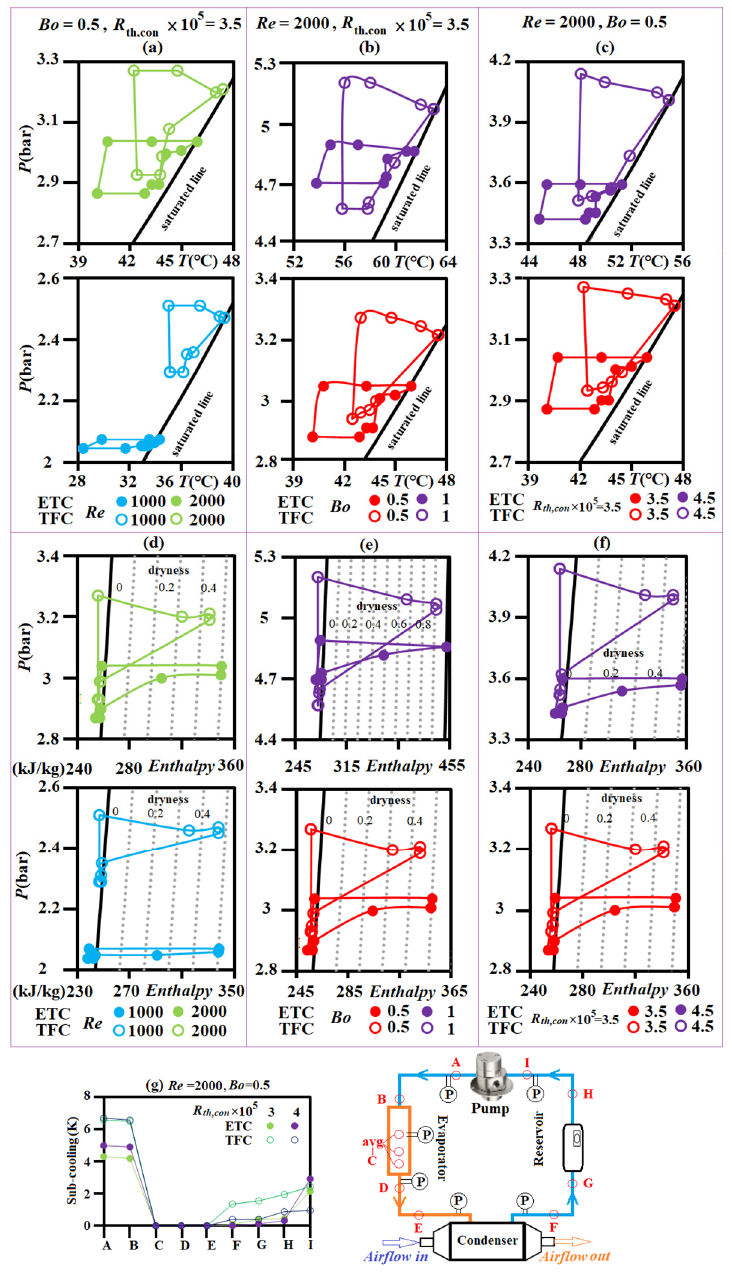
Figure 3. Thermodynamic cycles of the pumped thermosyphon loops with TFC and ETC in P-T and P-H diagrams for revealing the isolated impacts of ( a , d ) Re , ( b , e ) Bo ( c , f ) R th ,con . ( g ) sub-cooling temperatures along loops at Re = 2000, Bo = 0.5 with R th ,con = 4 × 10 − 5 and 3 × 10 − 5 .